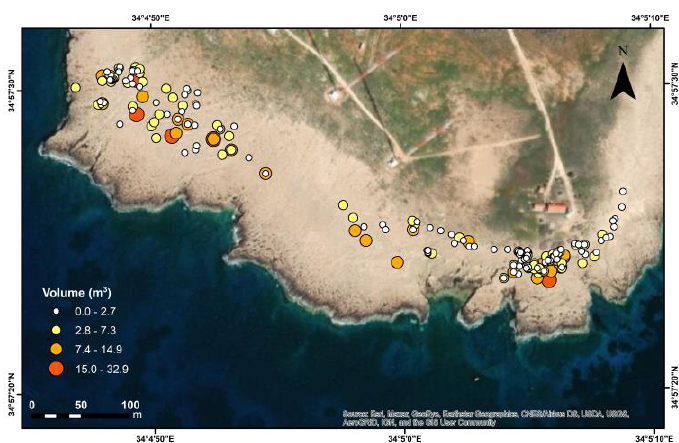
Figure 6. Distribution of studied boulders in the study area, according to their volume (m 3 ). Base map sources: Esri, DigitalGlobe, GeoEye, i-cubed, USDA FSA, USGS, AEX, Getmapping, Aerogrid, IGN, IGP, swisstopo, and the GIS User Community.